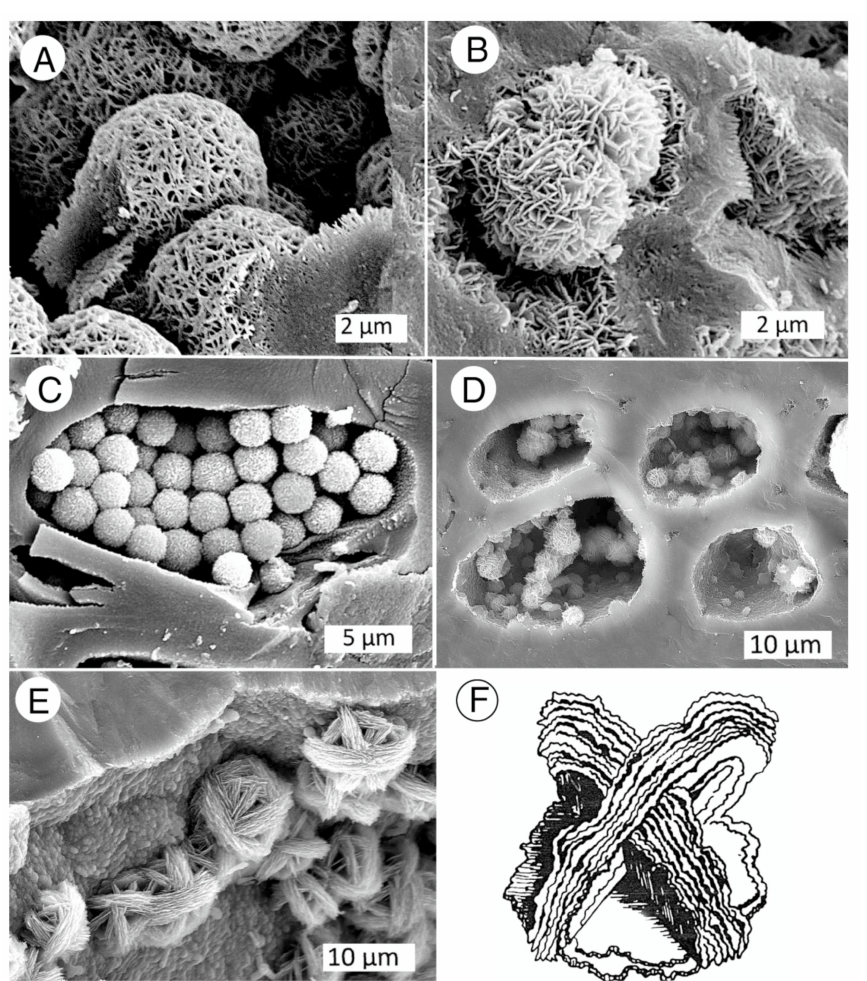
Figure 27. Miocene examples of opal-CT lepispheres. ( A , B ) Pandora Opal Mine, Virgin Valley, Nevada, USA. ( C ) Royal Peacock Opal Mine, Virgin Valley, Nevada, USA. ( D ) Georgia Nation specimen provided by Mirian Makazde. ( E ) Lepispheres showing twinned structure. Selah Butte, central Washington, USA. ( F ) Sketch showing a juvenile stage of opal-CT lepisphere formation where twinning of blades occurs at 70 ◦ angles, corresponding the faces of a cristobalite octahedron. Sketch adapted from [34]. In all of these examples, crystal shapes can be seen only in areas that